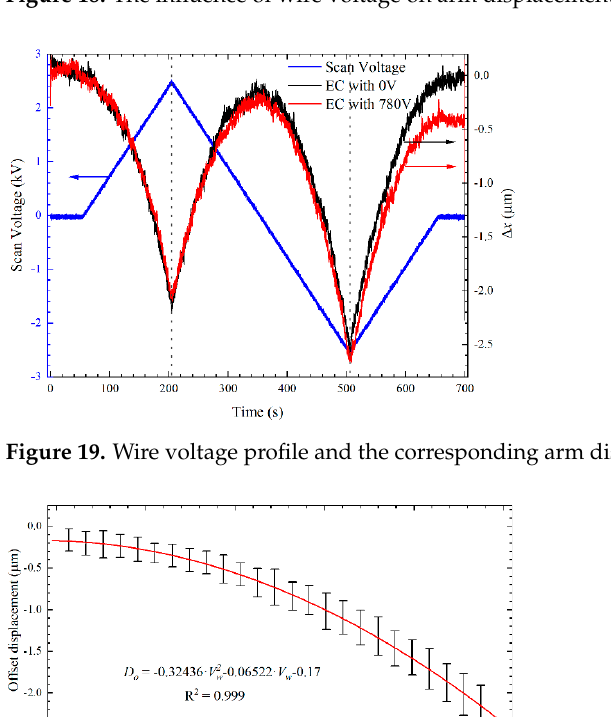
Figure 18. The influence of wire voltage on arm displacement reading.